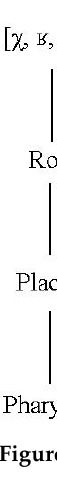
Figure 12. Feature geometry of English /h/.